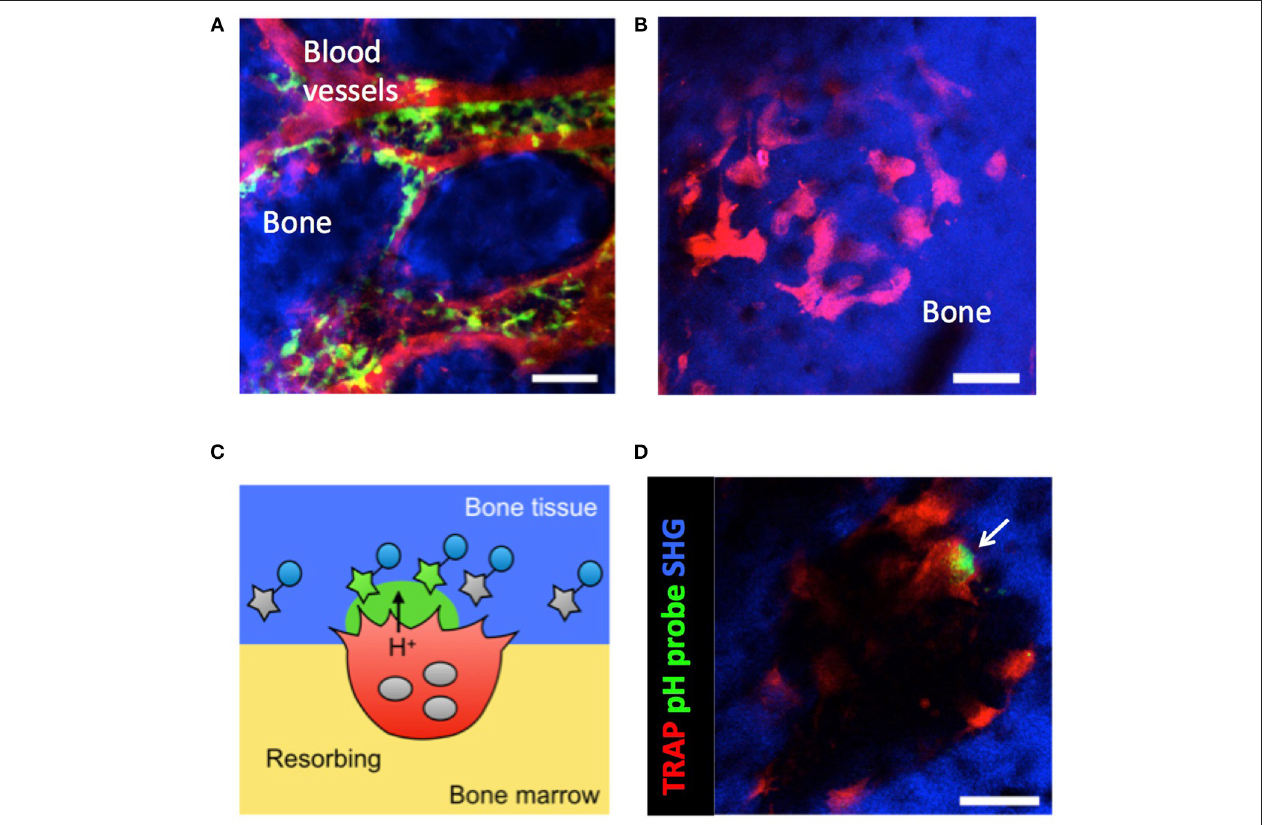
FIGURE 1 | Intravital imaging of CX 3 CR1 + osteoclast precursors and mature osteoclasts in the bone marrow. (A) Image of the calvaria of CX 3 CR1-EGFP knock-in mice taken by two-photon microscopy. Osteoclast precursors are CX 3 CR1-EGFP + (green). Blood vessels were stained via intravenous injection of Texas Red-conjugated dextran (red). Scale bar: 50 µ m. The maximum intensity projections (MIPs) of two-dimensional image stacks of vertical calvarial slices are shown. (B) Images of the calvaria of TRAP-tdTomato transgenic mice taken by two-photon microscopy. Mature osteoclasts are tdTomato + (red). Scale bar: 50 µ m. Second harmonic fluorescence generated from two-photon excitation of collagen fibers defines the bone matrix (blue). The maximum intensity projections (MIPs) of two-dimensional image stacks of vertical calvarial slices are shown. (C) Schematic diagram of osteoclast localization and activity evaluation using a pH-sensing fluorescent probe. (D) Representative intravital two-photon images of the bone marrow of heterozygous TRAP-tdTomato transgenic mice treated with a pH-sensing fluorescent probe. Mature osteoclasts expressing TRAP-tdTomato signals (red), fluorescent signals from high H + concentration (green), and second harmonic generation (SHG) defining the bone matrix. Some green fluorescent signal (arrow) could be detected along the bone surfaces near to osteoclasts. Scale bars: 50 µ m. A two-dimensional image of the calvaria is